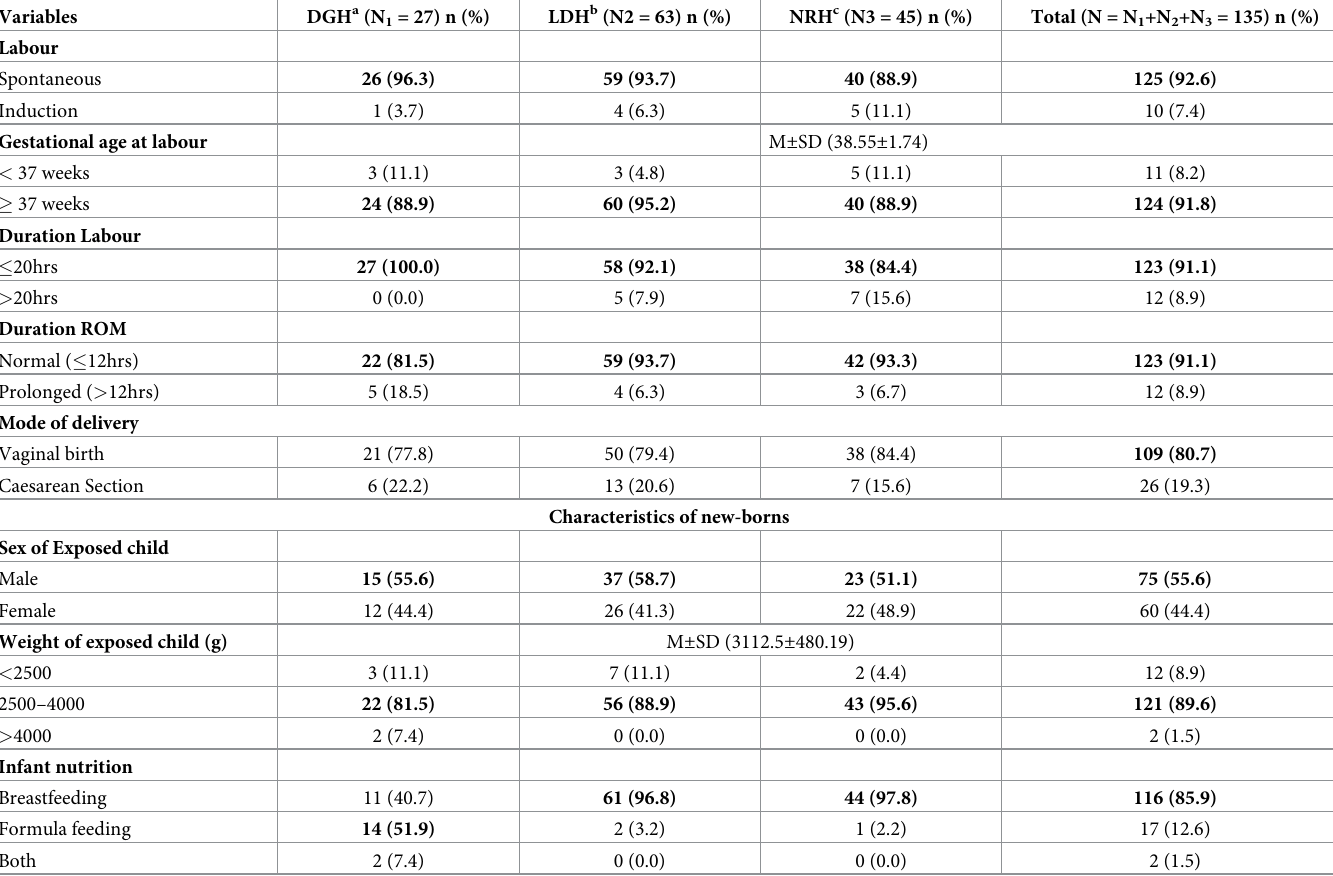
Table 3. Characteristics of labour, delivery and